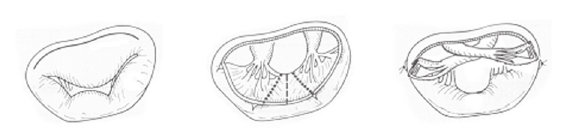
Fig. 1 - Papilopexia cruzada